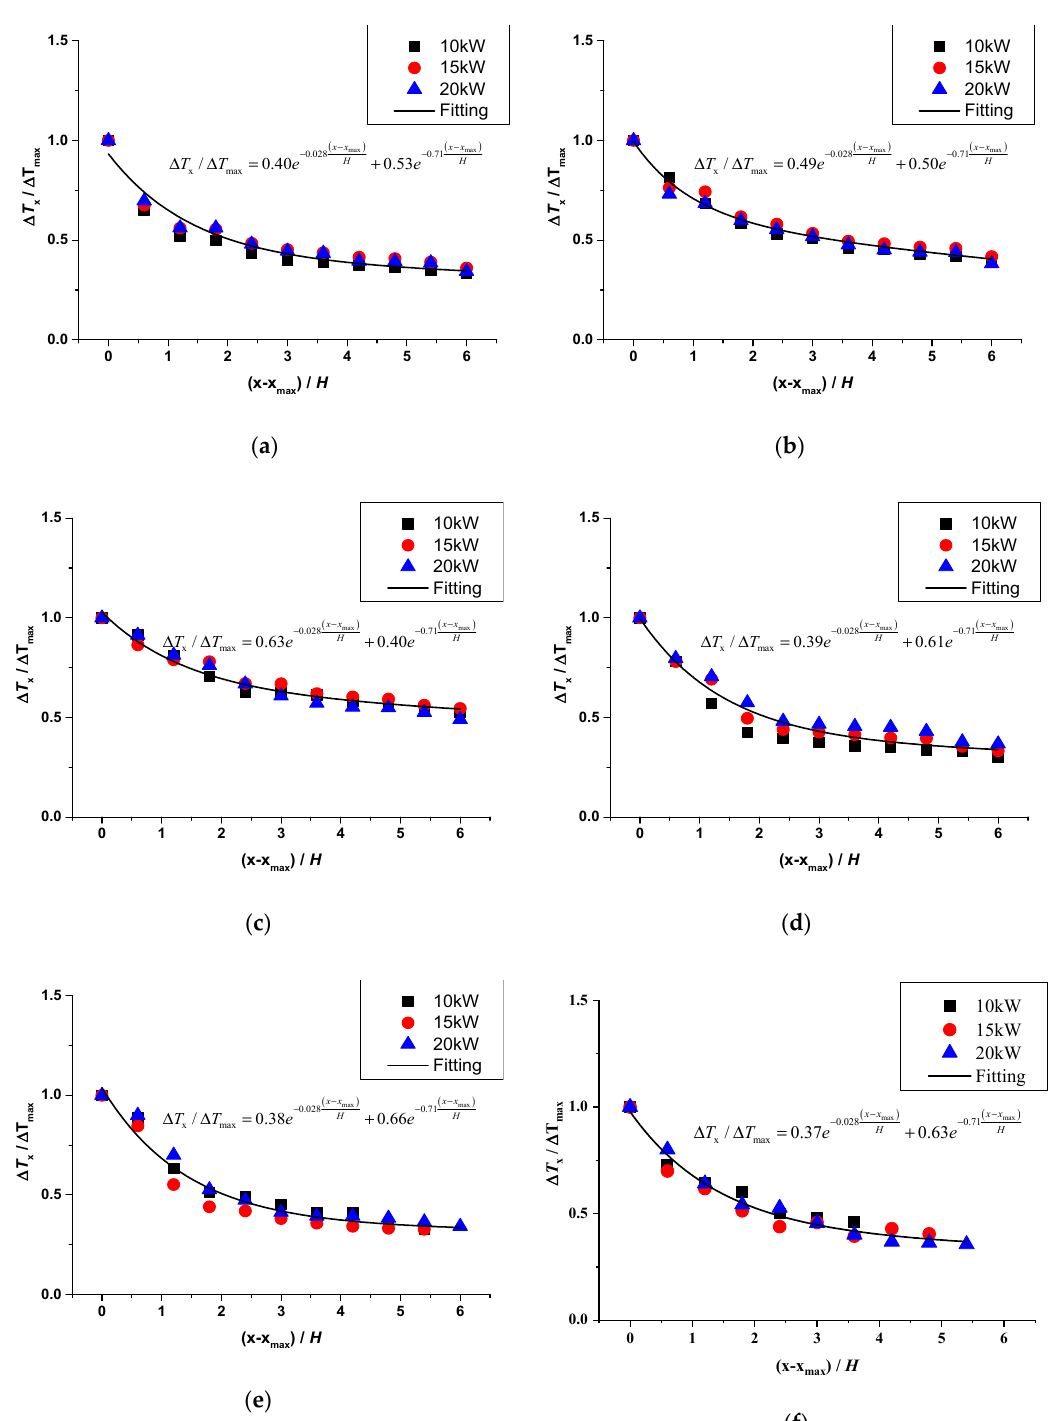
Figure 10. Ceiling temperature distribution relative to distance for corridor open to the environment: ( a ) 0 m/s; ( b ) 0.2 m/s; ( c ) 0.5 m/s; ( d ) 0.85 m/s; ( e ) 1.24 m/s; ( f ) 1.52 m/s.